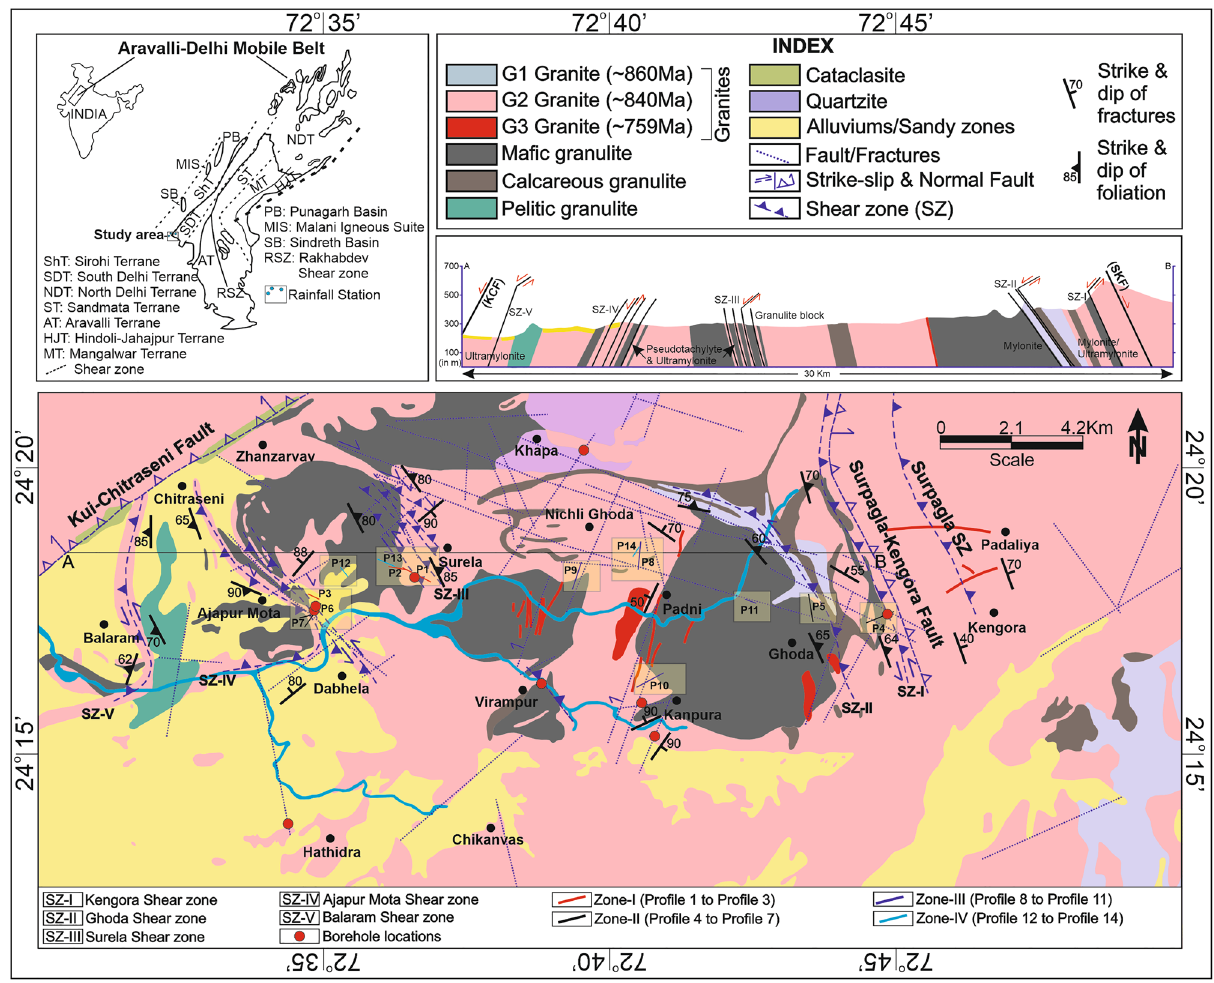
Figure 1. Geological and structural map of the study area with major shear zones, fracture, faults, and litho- units. Inset shows the Aravalli-Delhi Mobile belt (ADMB) and associated terranes. The square box (shaded yellow) shows the geophysical survey sites